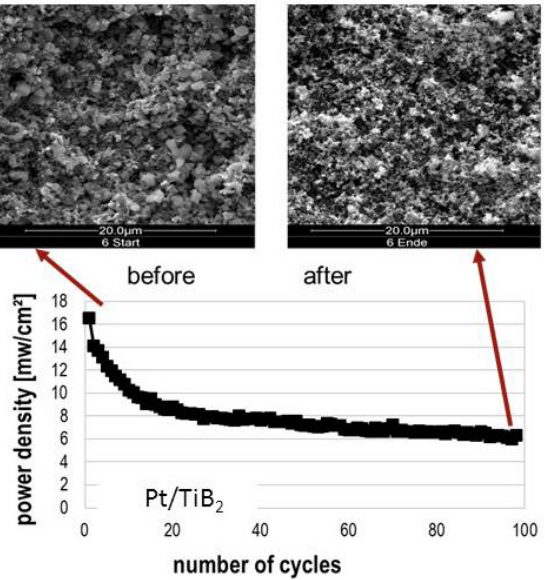
Figure 5. Decline of power output during fuel cell operation and comparison of the corresponding SEM images before and after